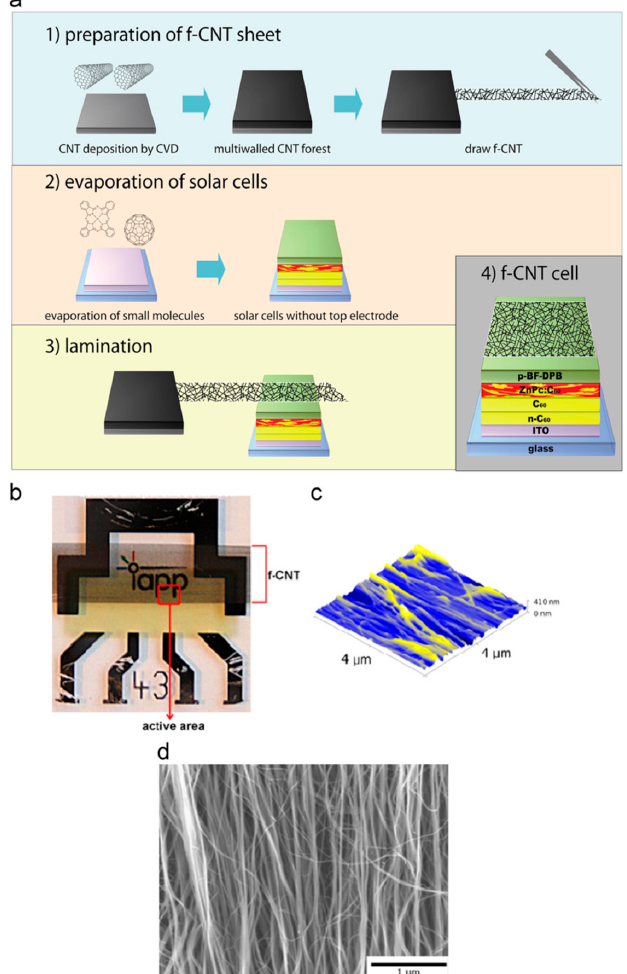
Figure 11. ( a ) Fabrication process f-CNT cell ( b ) a photograph of an f-CNT cell ( c ) AFM 4 × 4 μ m ( d ) SEM image of f-CNT sheet on the top of solar cell [132].